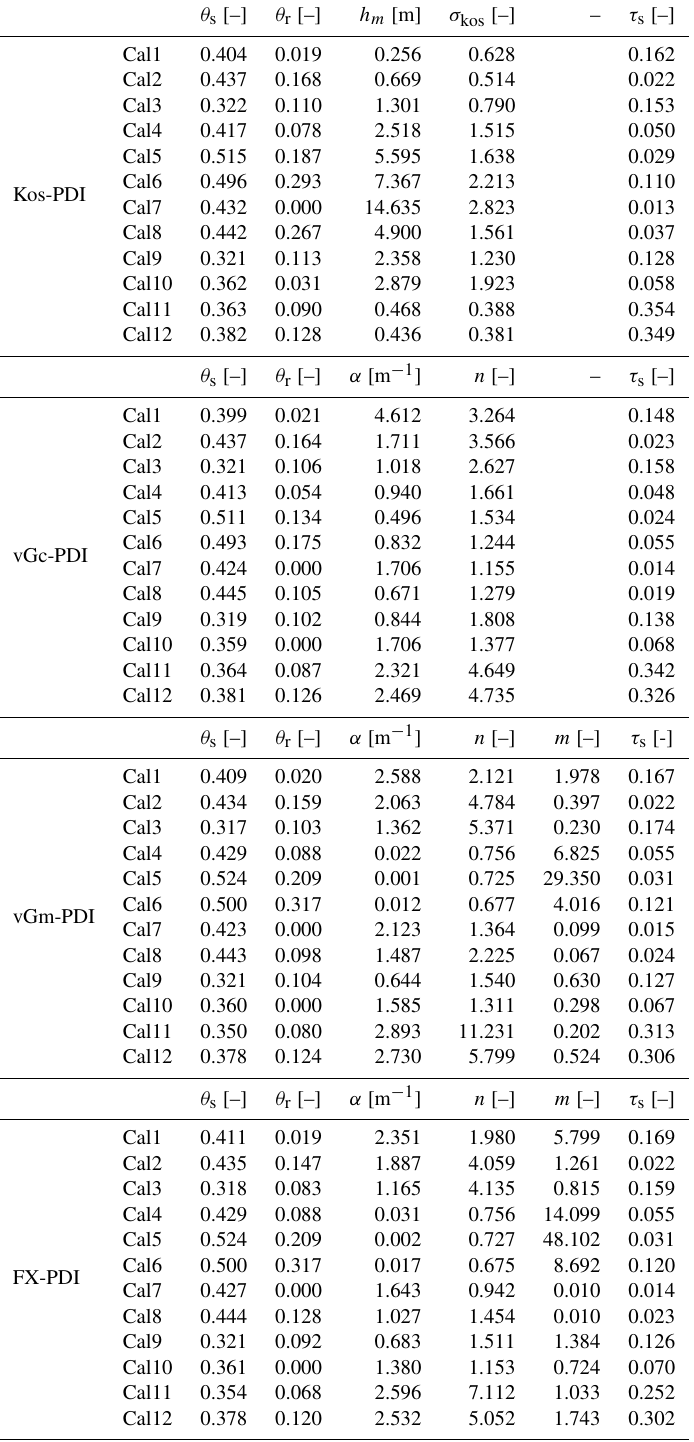
Table B1. Estimated parameter values for all four model combinations for the calibration data